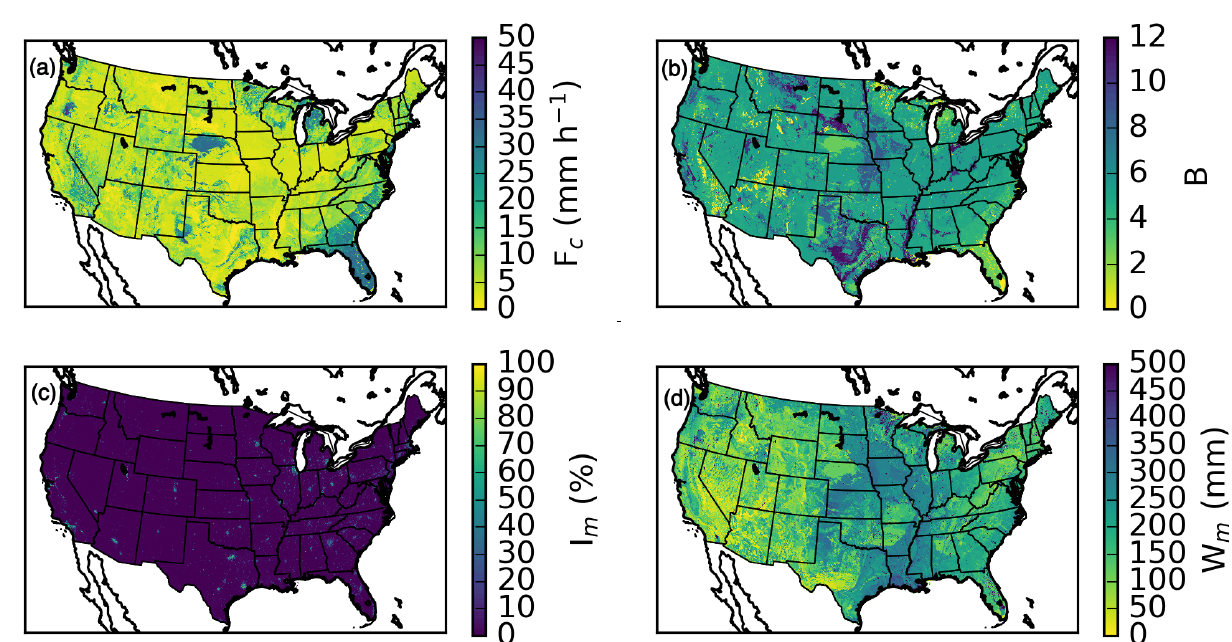
Table 1. Description of parameters used in the CREST water balance model. Parameter Description Value Grid source Min Mean Max W m Water capacity of soil in mm 1 Miller and White (1998) 0 206 2500 F c Saturated hydrologic conductivity in mmh − 1 1 Miller and White (1998) 0 8 51 b Exponent of the infiltration curve 1 Miller and White (1998) 0 5 12 I m Percentage impervious area in % 1 Xian et al. (2011) 0 1 96 K e Potential evapotranspiration adjustment factor 1 NA NA NA NA I wu Initial soil saturation in % 75 NA 0 NA 100 NA: not available.